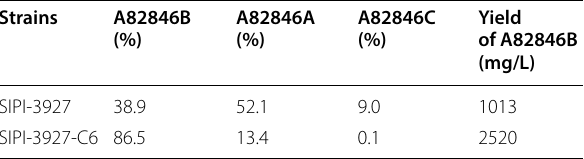
Table 4 Comparison the yield and ratio of A82846 in 5-L fermentation